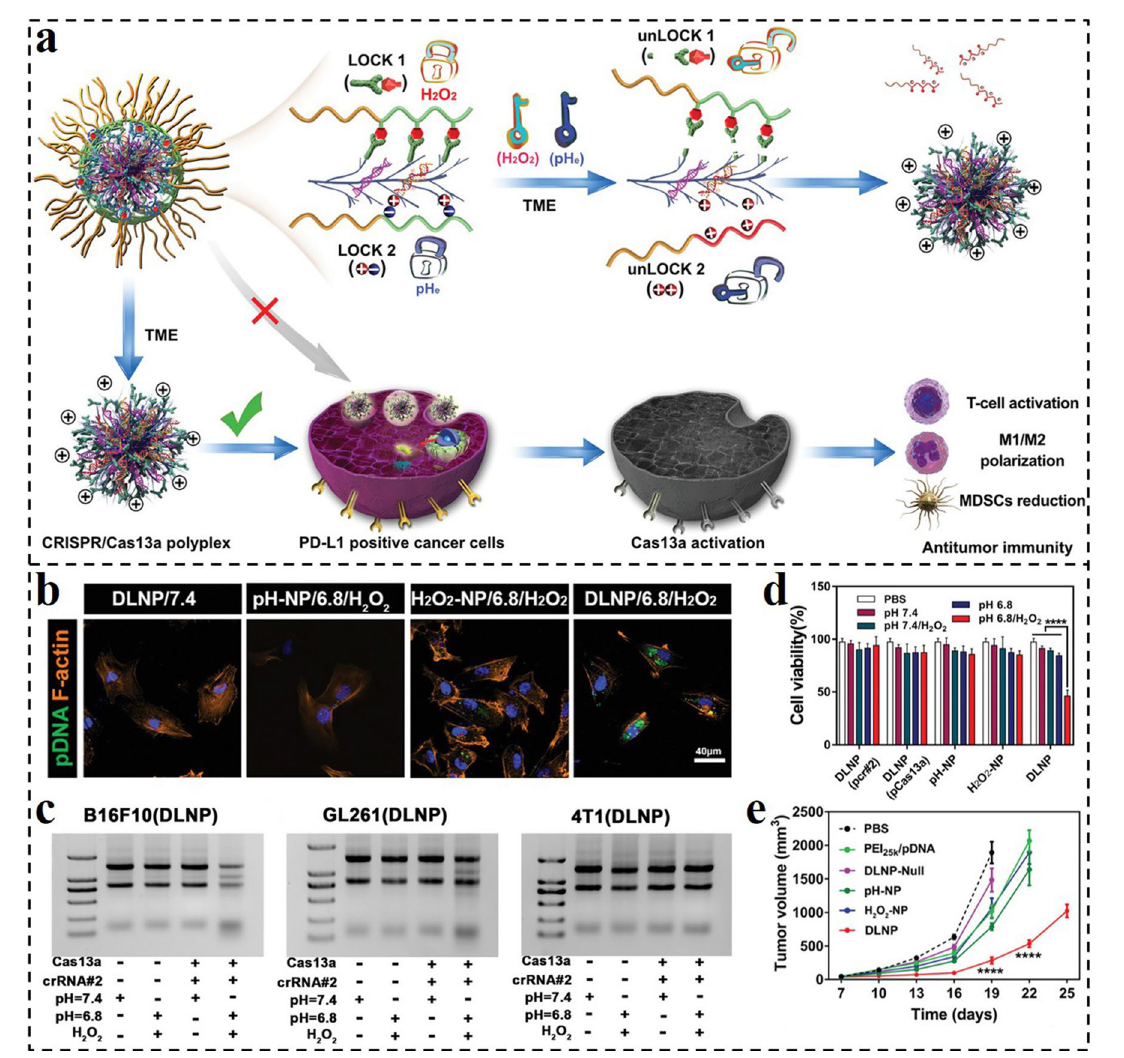
Fig. 18 a Schematic representation of DLNP for effective cancer immunotherapy. Similar to dual-lock safes that can only be opened when both locks are unlocked, DLNP can only release the CRISPR/Cas13a system in a microenvironment where both a low pH e and high H 2 O 2 concentra- tion are present. b CLSM analysis of intracellular delivery of different formulations to U87MG cells after 2 h of incubation under different con- ditions. c RNA denaturing gel of B16F10, GL26, and 4T1 cells after being treated with DLNP at different conditions for 60 h. d Cell viability of B16F10 cells after being treated with different formulations under different conditions for 60 h. e Average tumor growth kinetics in different groups [186]. Copyright 2019, Wiley–VCH